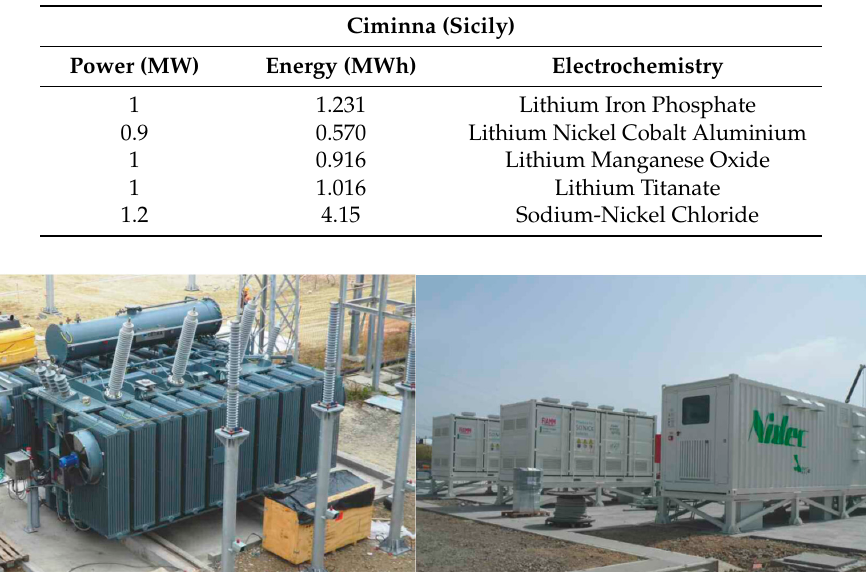
Table 4. Different storage technologies installed in Ciminna (Sicily).